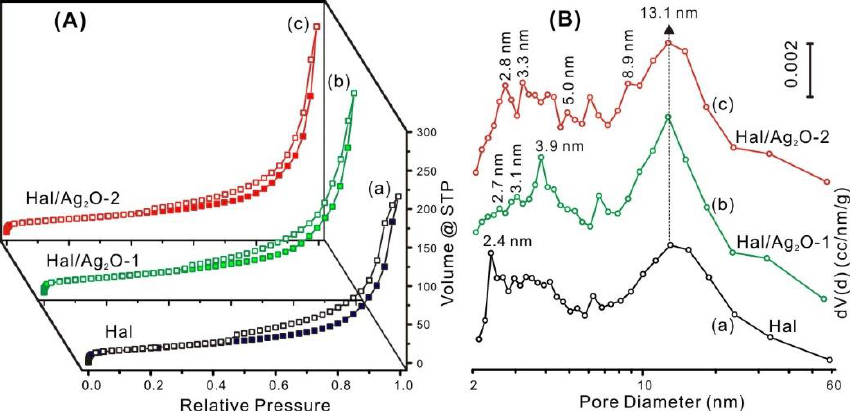
Figure 3. ( A ) N 2 adsorption – desorption isotherms of (a) Hal, (b) Hal/Ag 2 O-1, and (c) ( B ) PSD curves of (a) Hal, (b) Hal/Ag 2 O-1, and (c) Hal/Ag 2 O-2. Hal/Ag 2 O-2; ( B ) PSD curves of (a) Hal, (b) Hal/Ag 2 O-1, and (c) Hal/Ag 2 O-2. Two distinct mesoporous populations centered ca. 2.4 nm and 13.1 nm, Two distinct mesoporous populations centered ca. 2.4 nm and 13.1 nm, respectively,